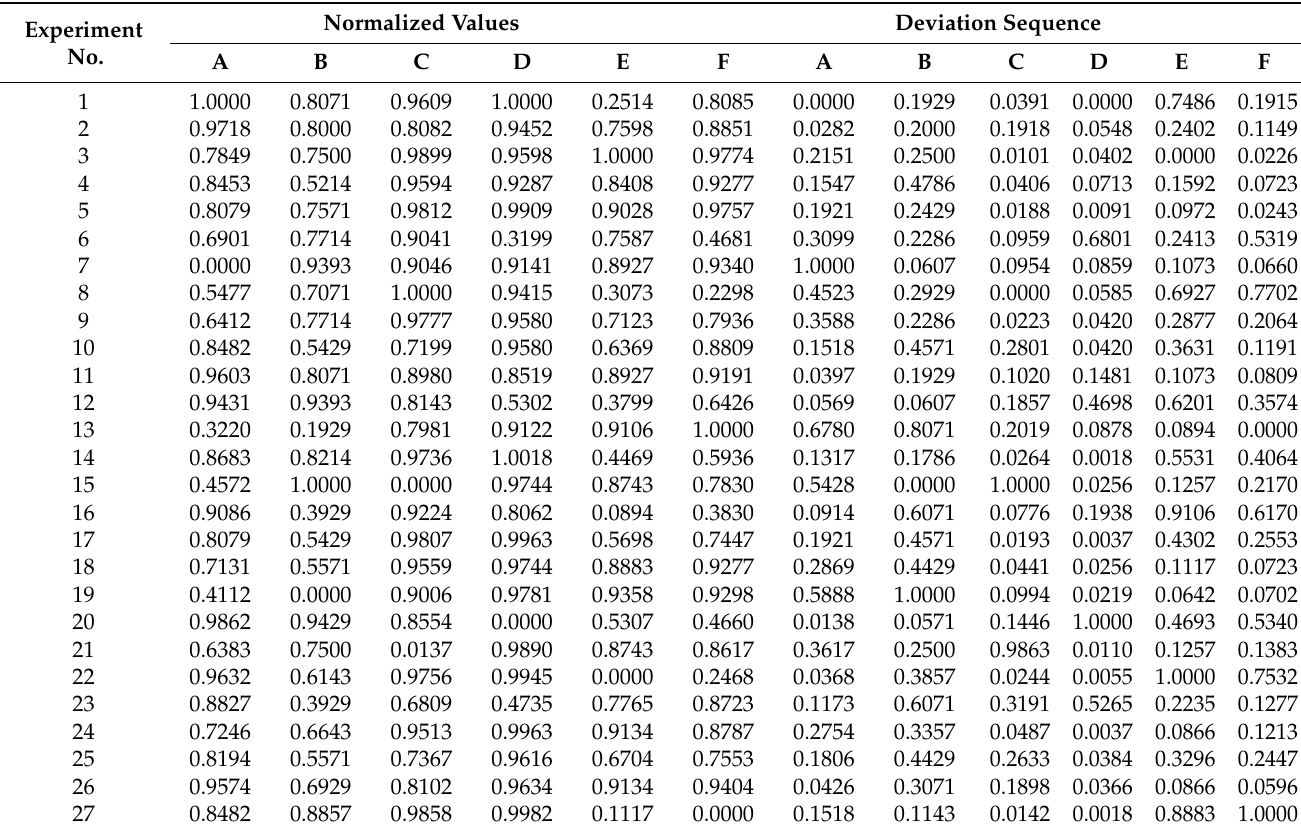
Table 5. Normalized values and deviation sequences of the output